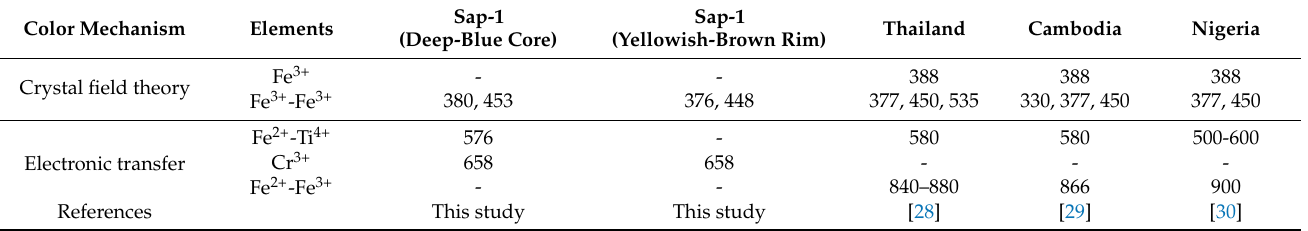
Table 2. Comparison of UV–Vis spectra (nm) of the Penglai sapphire with other basaltic sapphires. Color